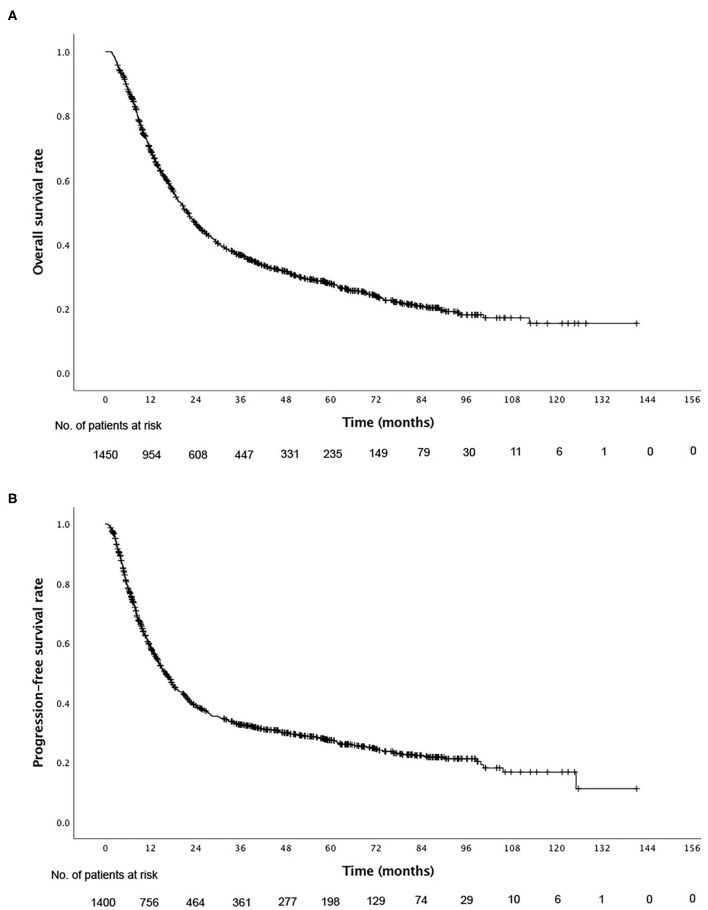
Kaplan–Meier curves of (A) overall survival and (B) progression-free survival for all patients.